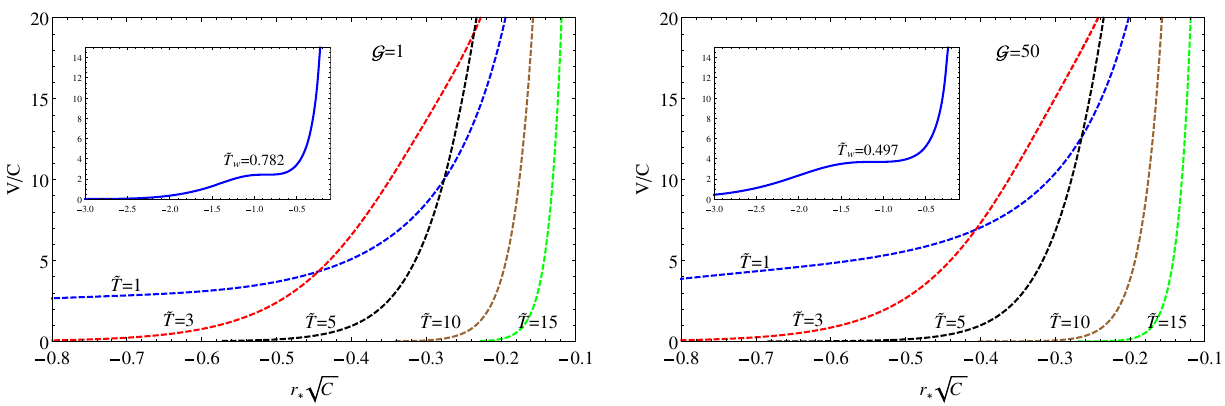
Fig. 4 Effective potential with zero wavenumber for G = 1 (left panel) and G = 50 (right panel) in the regime of intermediate and high temperatures. We also show the potential for (cid:10) T = (cid:10) T w in the inset